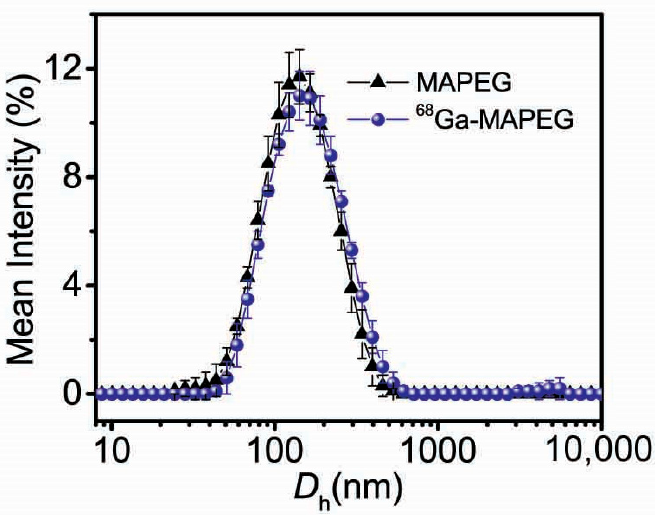
Figure 2. Representative radio-TLC chromatograph of [ 68 Ga]Ga-MA or [ 68 Ga]Ga-MAPEG obtained after 30 min of incubation at 75 °C.